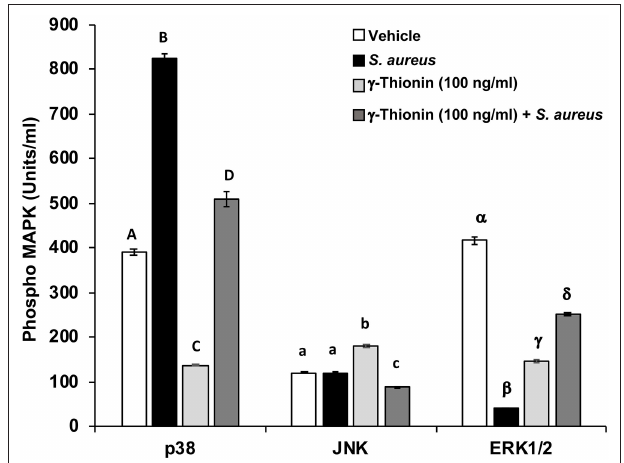
FIGURE 1 | p38, JNK, and ERK1/2 activation regulated by γ -thionin in bMECs. MAPK phosphorylation was measured in bMECs treated with γ -thionin (100ng/ml) by flow cytometry. Each bar shows the mean ± SD of 3,000 events acquired using a Flex Set Cytometric Bead Array (CBA, Becton Dickinson). Data were obtained from two different experiments, which were run in duplicate ( n = 4). Different letters between each MAPK analyzed indicate significant differences (one-way ANOVA, post-hoc Tukey test P ≤ 0.05), within the treatments (capital letters for p38, lowercase letters for JNK, and Greek symbols for ERK1/2). Vehicle was DMSO